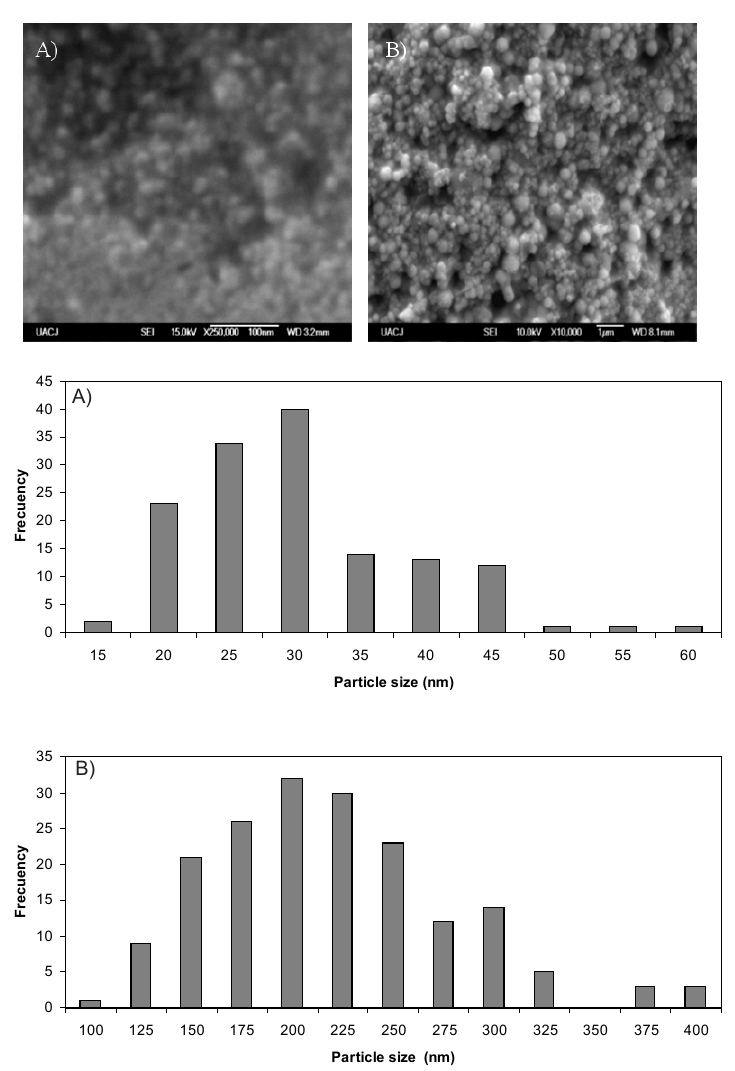
Figure 1. Micrograph and particle size distribution of magnetite particles obtained by A) chemical coprecipitation and B) chemical with reflux and aging.